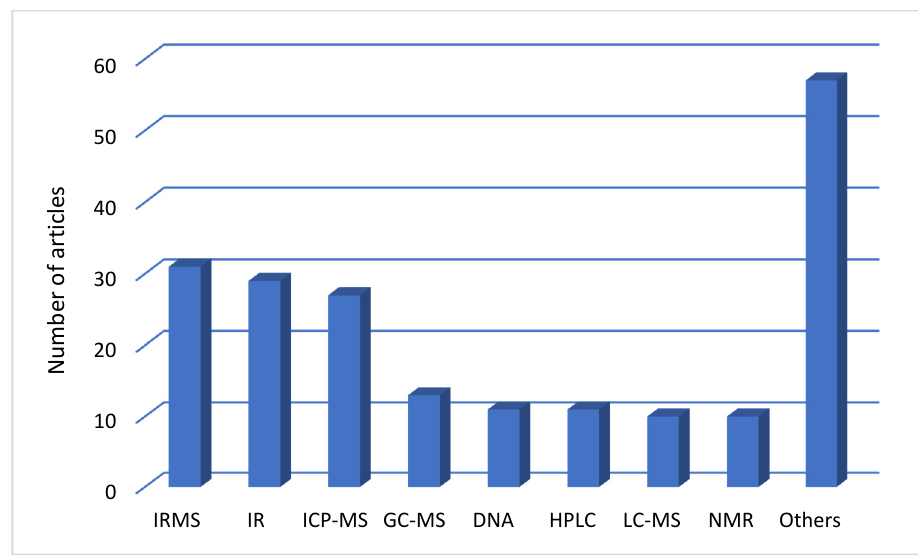
Figure 4. Articles according to the type the analytical techniques.